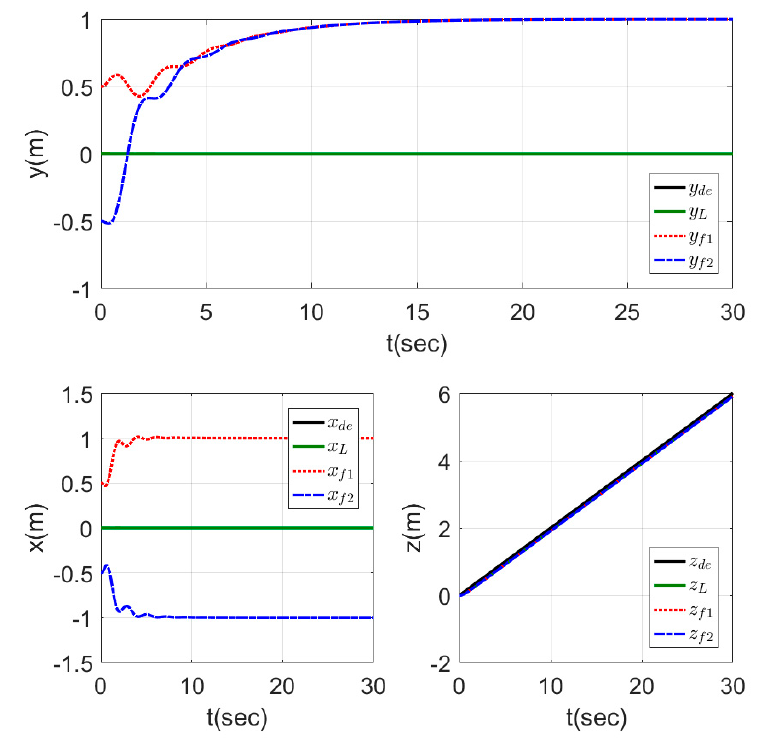
Figure 12. Time response of fixed triangle formation for MAS.